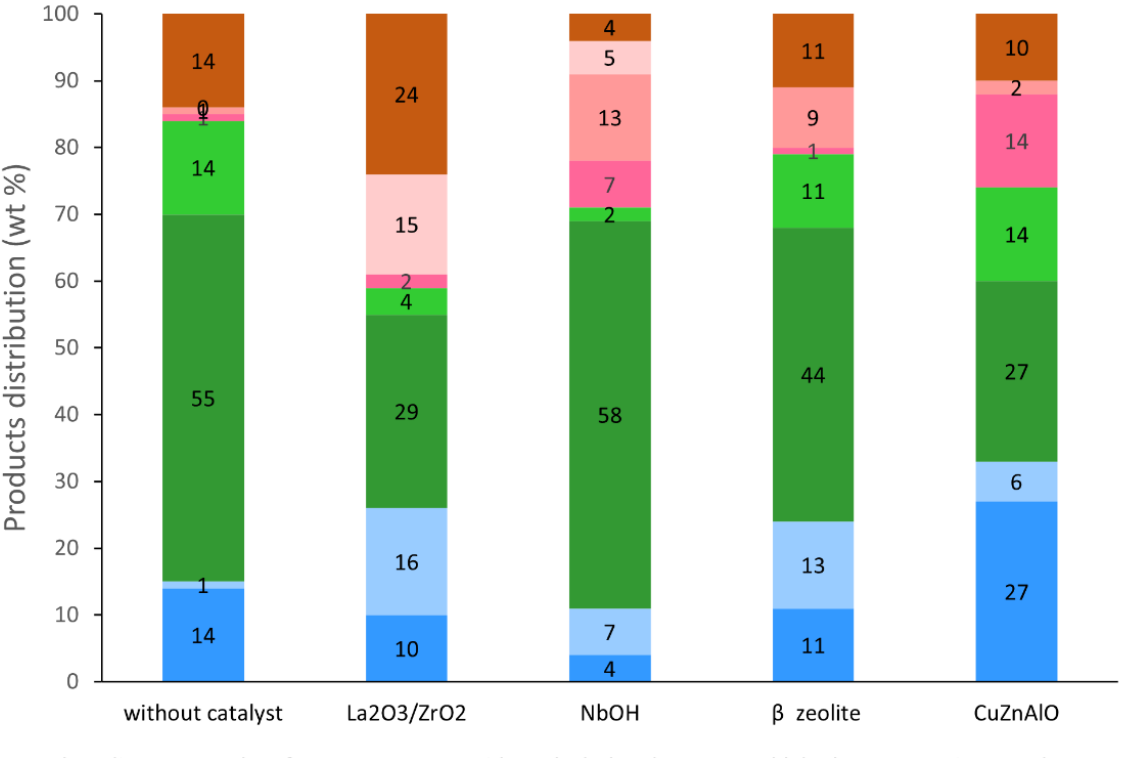
Figure 7. 100% distribution of light liquid products in the absence and presence of various catalysts. Fractionation of pine in SC ethanol at 250 ◦ C. Conditions: Batch reactor, pine 2.5 g, catalyst 1 g, ethanol 27 g, 1 h at 250 ◦